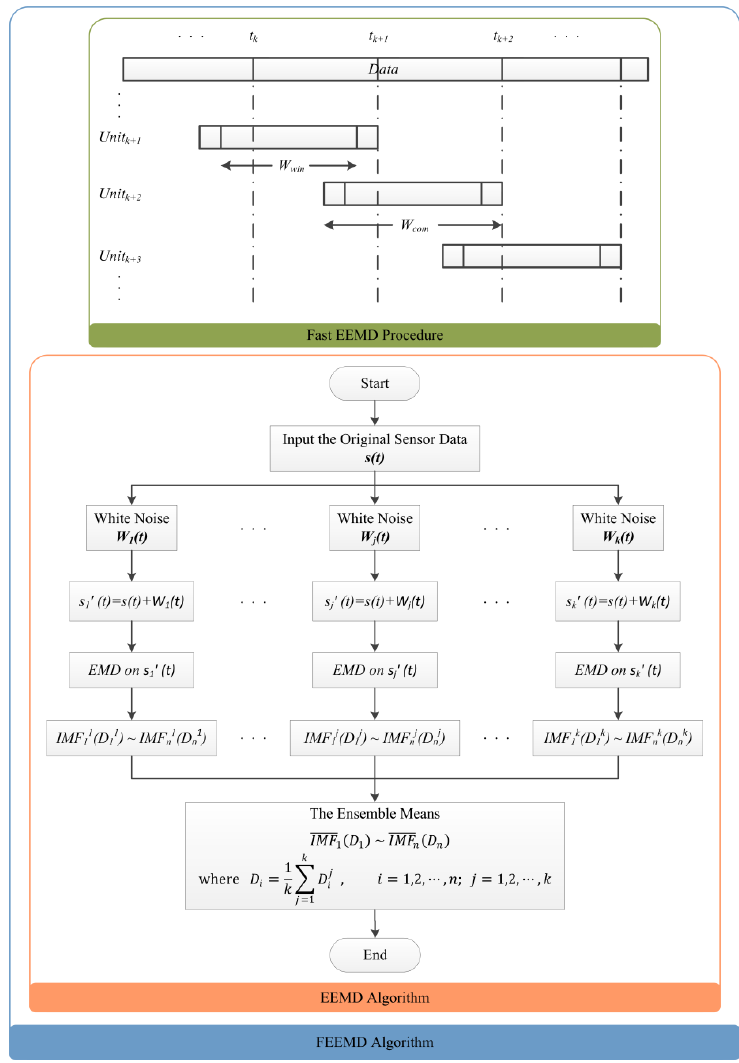
Figure 1. The fast ensemble empirical mode decomposition procedure.